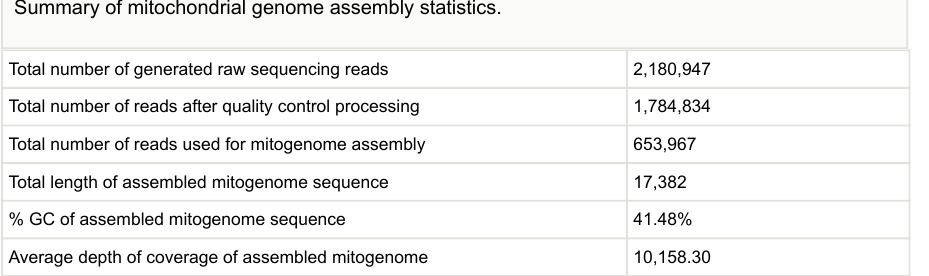
Summary of mitochondrial genome assembly statistics.